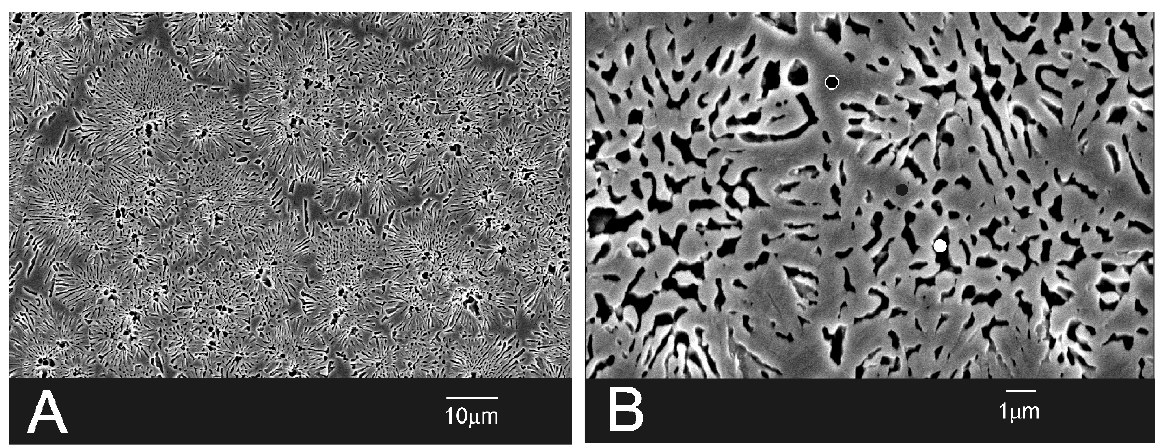
with dilute acid acetic ( ○ = TCP; ● = psW). ( A ) low magnification; ( B ) high